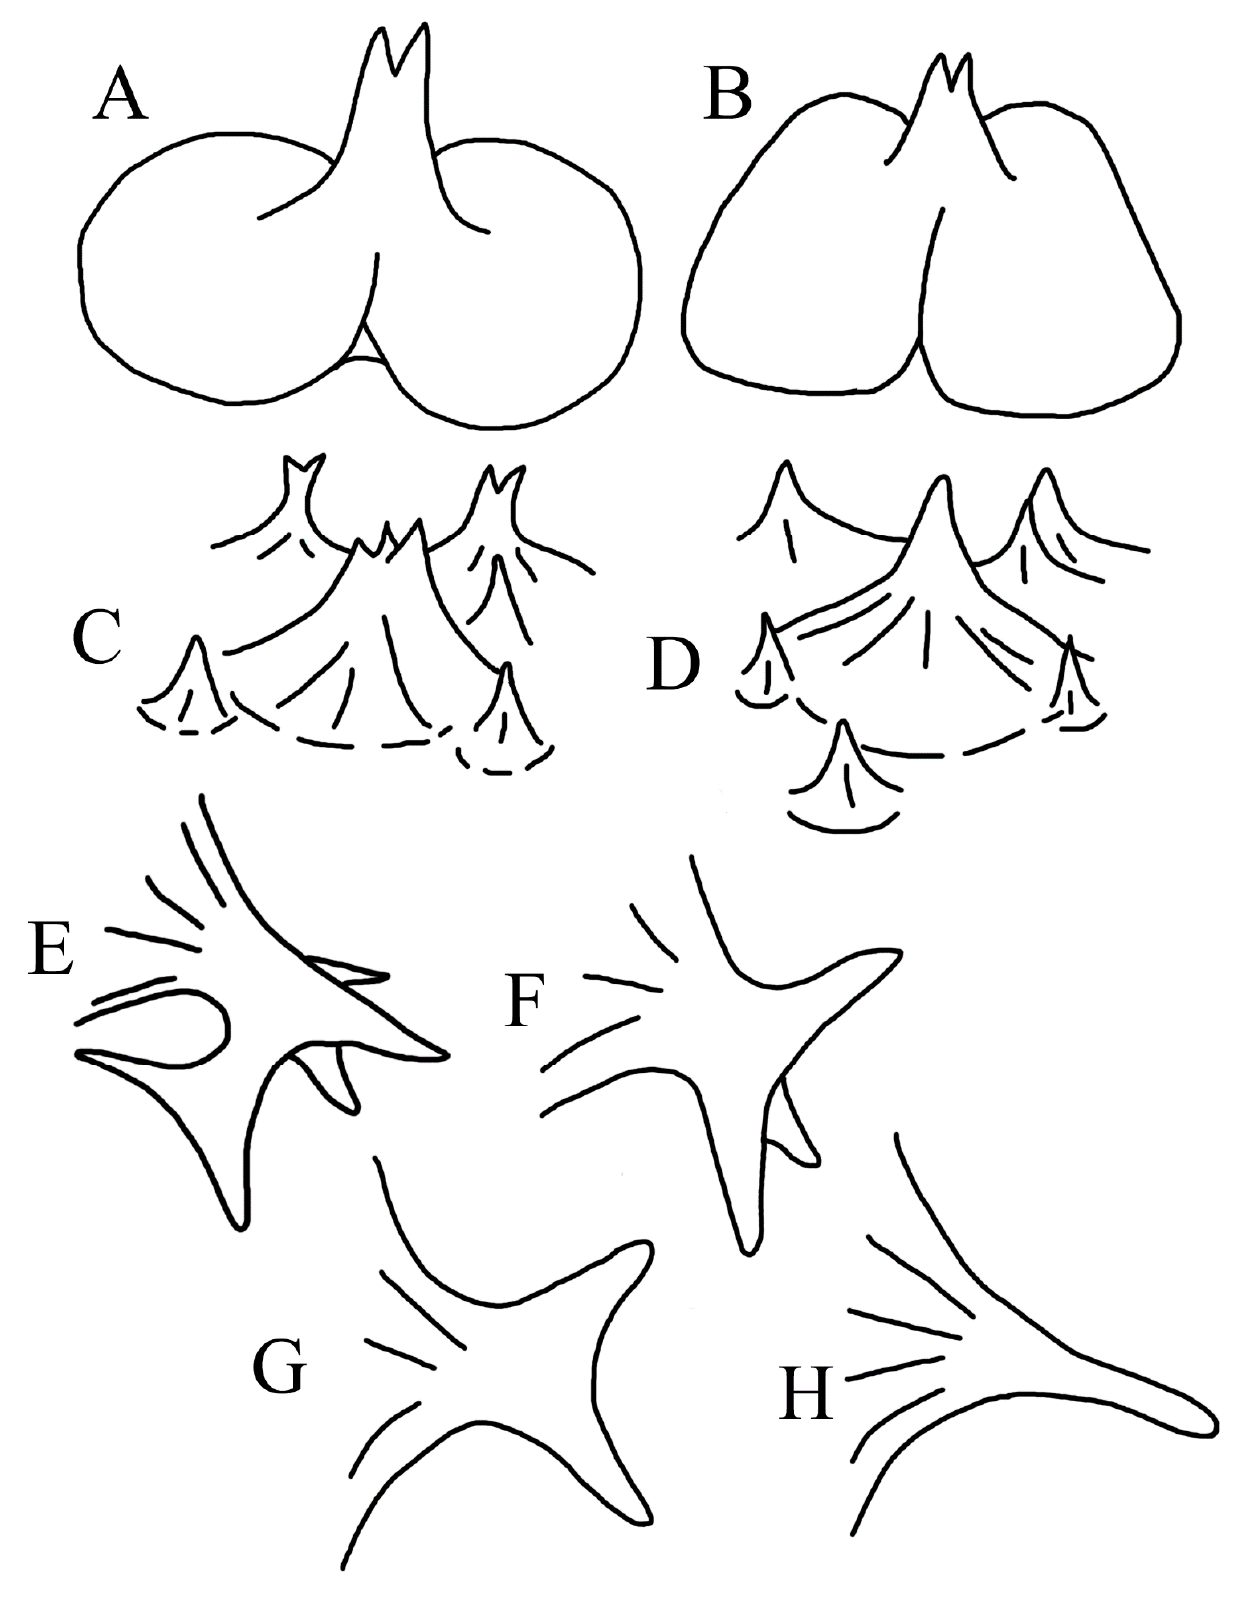
Figure 35. Esca and squamation of Halieutopsis stellifera (Smith and Radcliffe, 1912). ( A , B ). Esca. ( C , D ). Rostrum. ( E , F ). Subopercular tubercle. ( G ). Tubercle on disk margin. ( H ). Tubercle on tail. ( A , C , E , G) . AMS I.29824-002, 103.1 mm SL. ( B , D , F , H) . AMS I.22817-003, 78.7 mm SL.